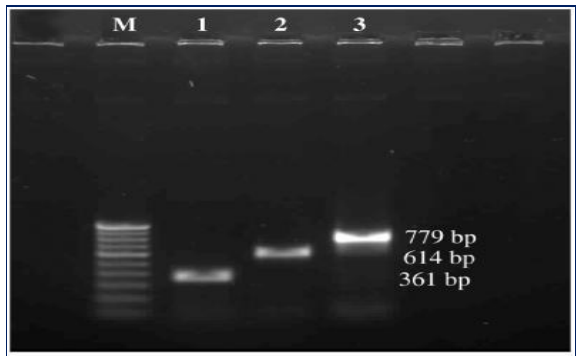
Figure, 1: Results of the PCR